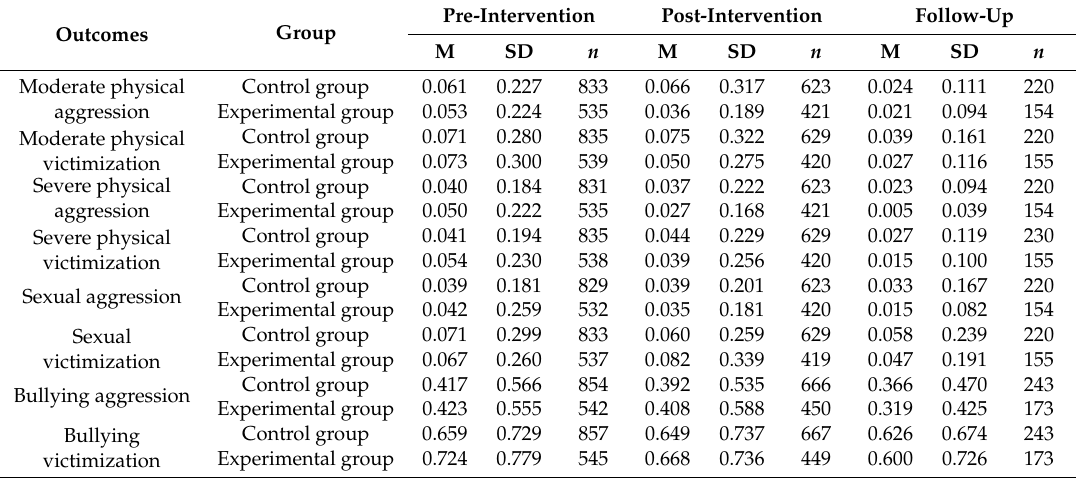
Table 2. Descriptive statistics in the three waves for primary and secondary